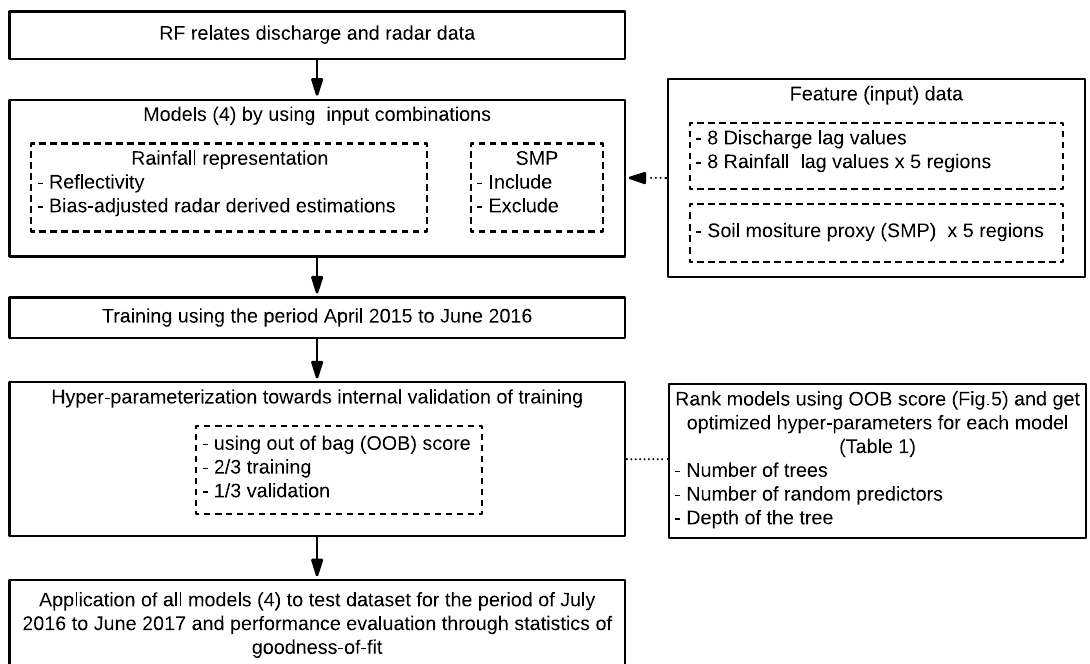
Figure 2. Workflow of the implementation of the RF models in the current study.